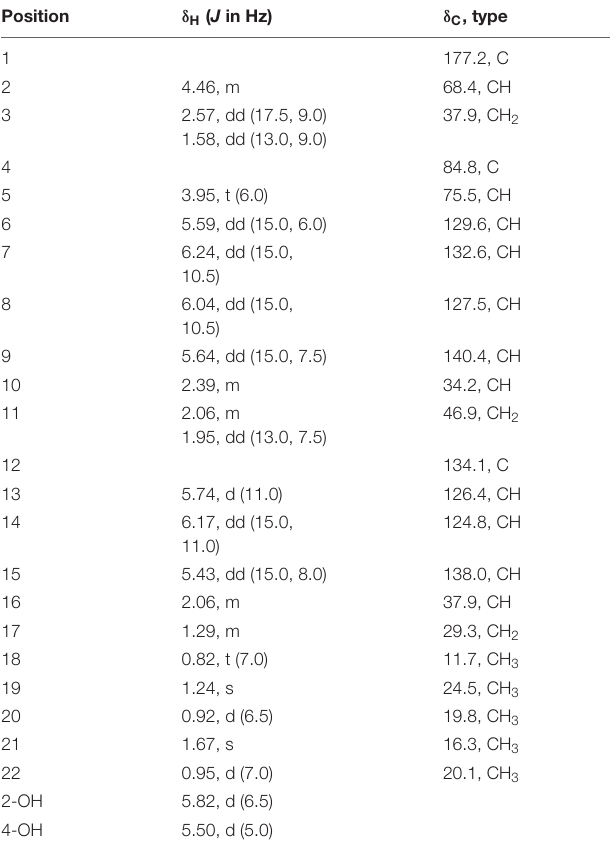
Frontiers in Microbiology |